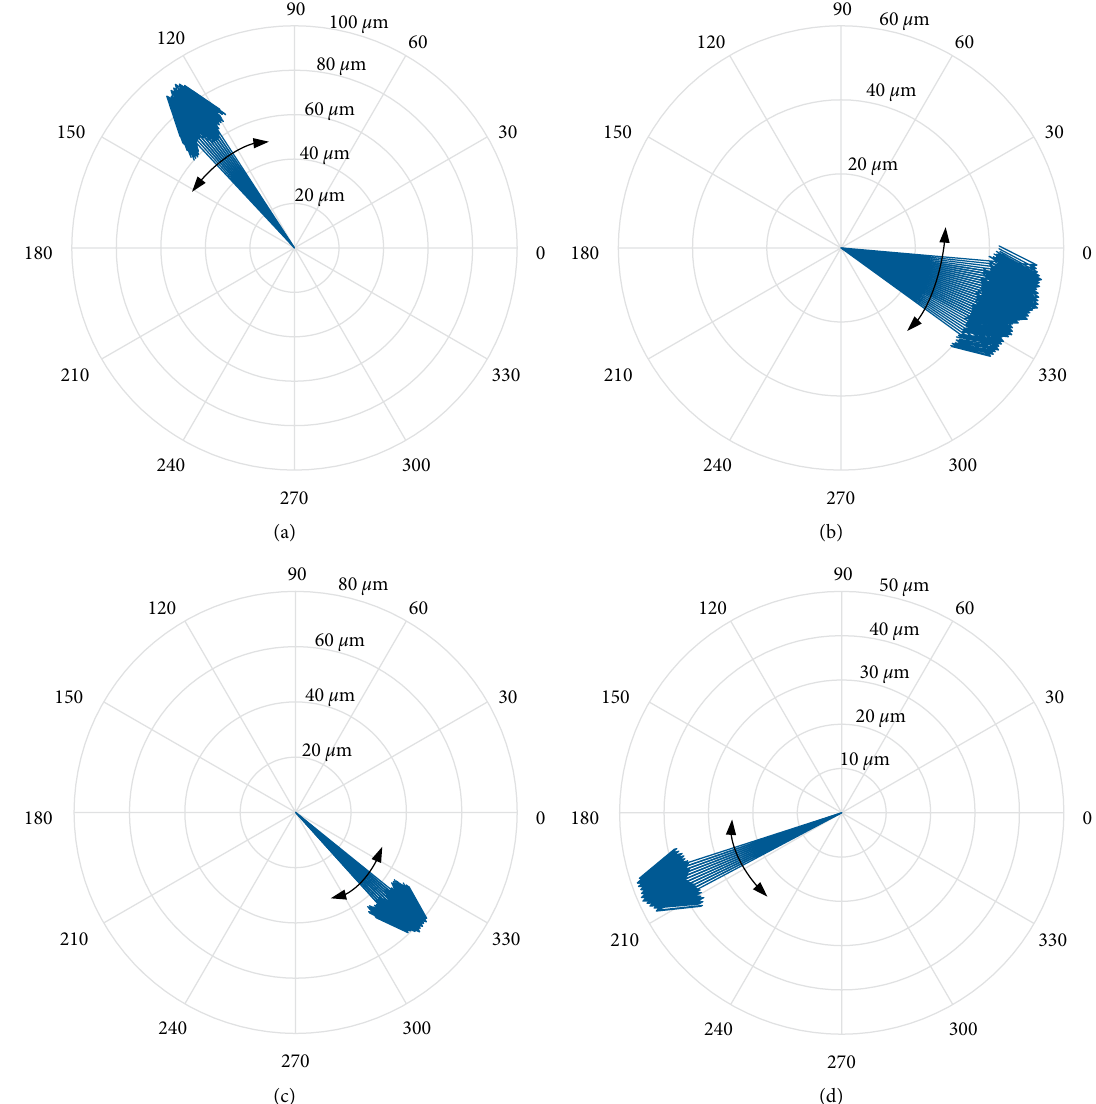
Figure 10: Changes of vibration vectors. (a) х -direction at bearing A. (b) y -direction at bearing A. (c) х -direction at bearing B. (d) y -direction at bearing B .